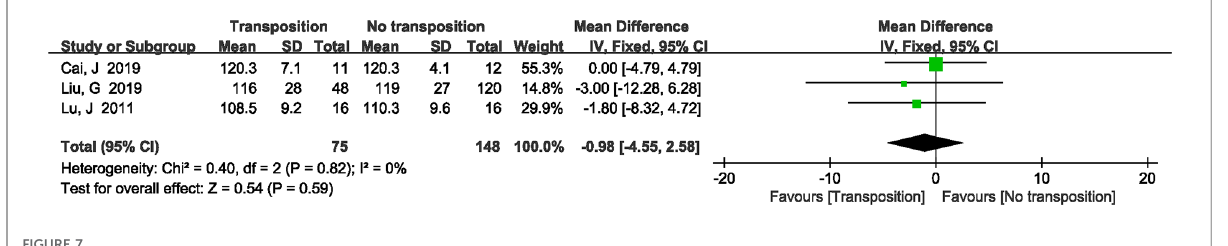
FIGURE 7 A forest plot showing the elbow joint motion.